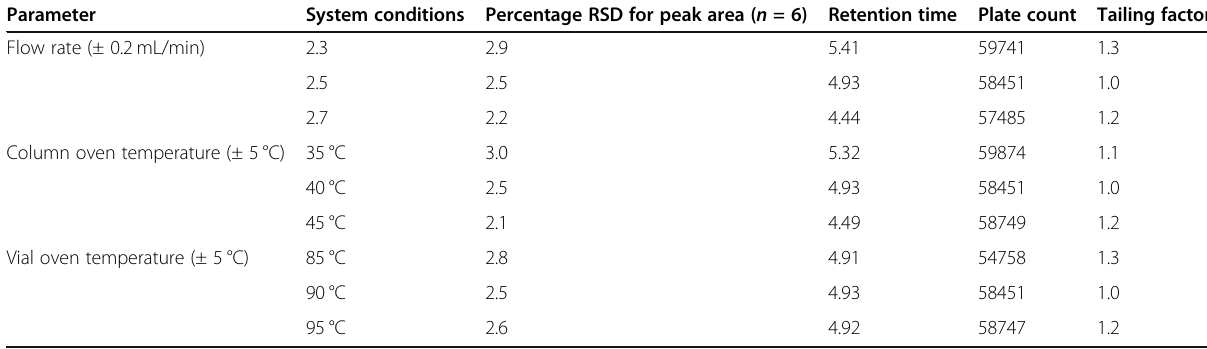
Table 19 Robustness study results of methanol